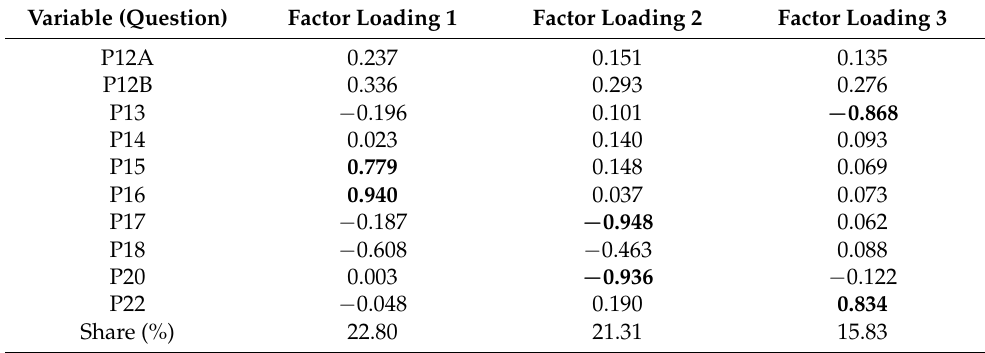
Table 2. Results of principal components analysis for economic function performed by the stud- ied